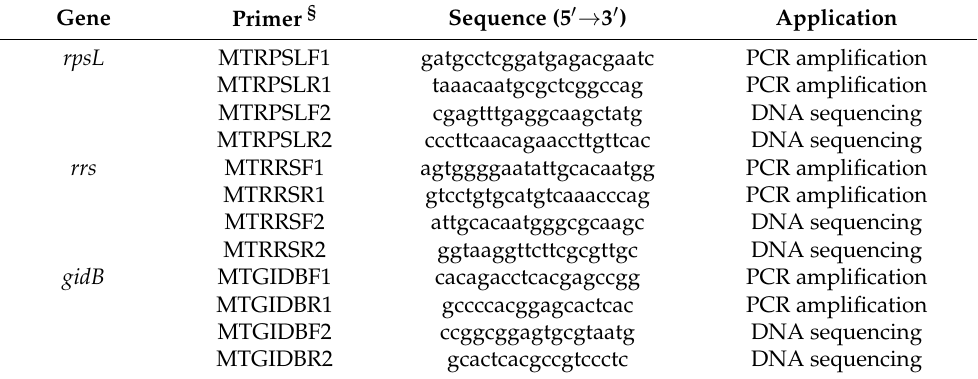
Table 5. Gene-specific primers for PCR amplification or DNA